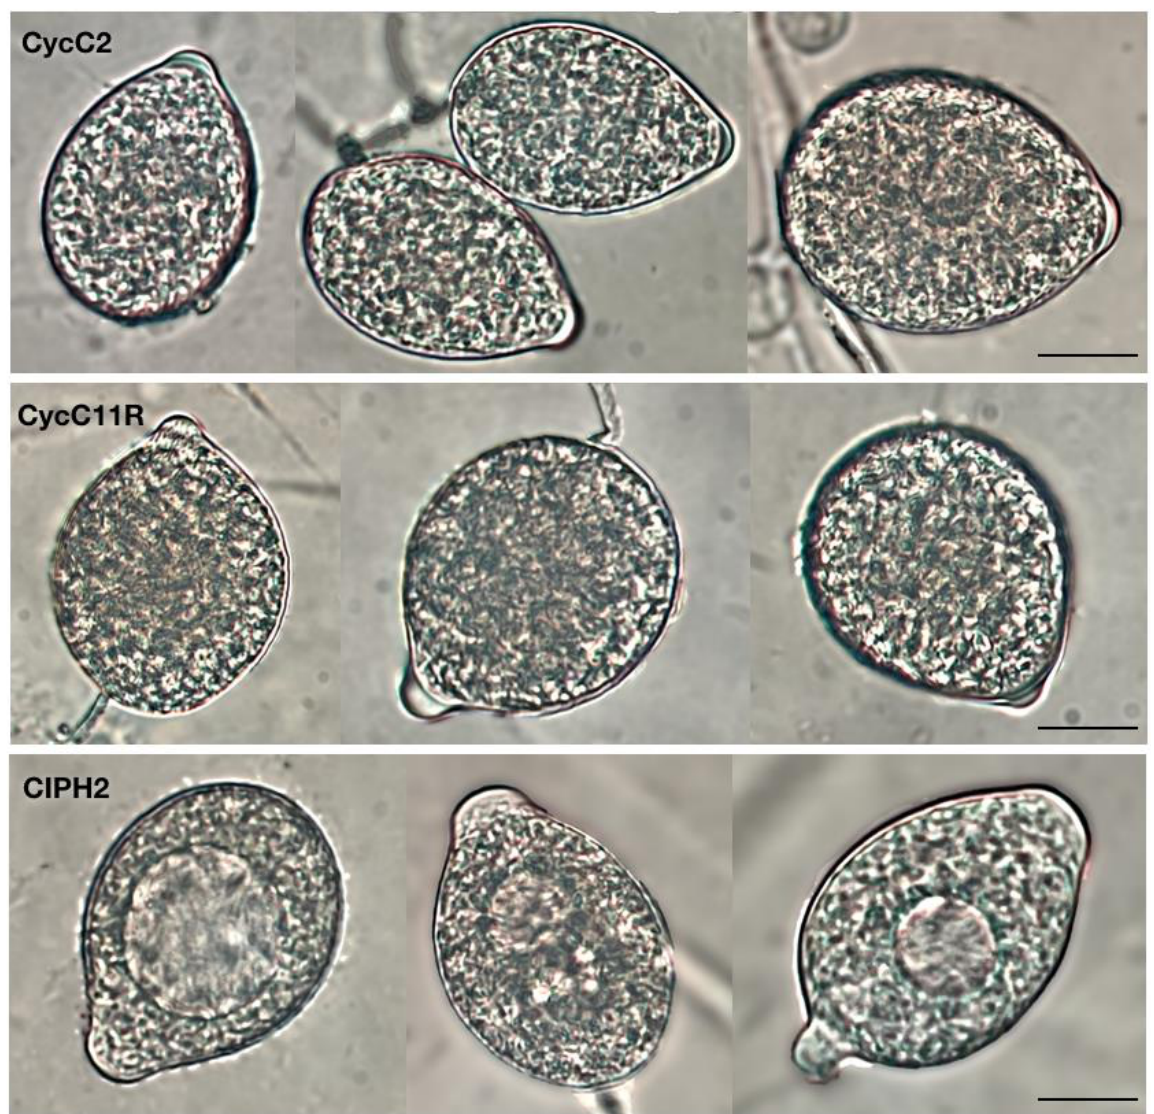
Figure 3. Semi-papillate, persistent, ovoid, limoniform, or ellipsoid sporangia of Phytophthora multivora (CycC2). Papillate, persistent, spherical to ovoid, ellipsoid, obpyriform sporangia of P. nicotianae (CycC11R). Non-papillate, persistent, terminal, ovoid, ellipsoid to obpyriform sporangia of P. pseudocryptogea (CIPH2). Scale bar: 25 μ m.